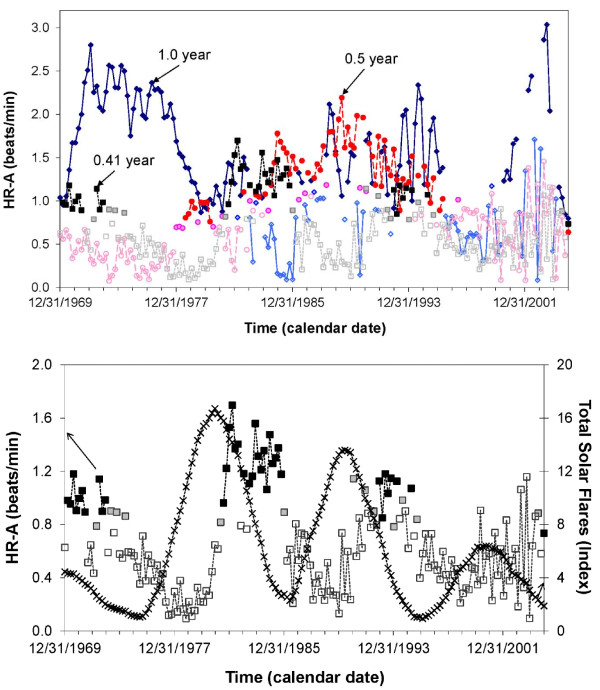
Multiple-component serial section. Heart rate, self-measured a few times each day by a healthy man over several decades, was averaged over consecutive weeks. The weekly averages are fitted with a 3-component model consisting of cosine curves with periods of 1.0, 0.5, and 0.41 year in a 4-year interval moved by 0.2 year throughout the entire record. The time course of amplitudes of the 3 components is shown on top. Solid-filled, light-filled and empty symbols correspond to P-values <0.05, 0.05 < P < 0.10, and >0.10 from the zero-amplitude tests, respectively. Results for the 0.41-year component are reproduced below, where they are compared with the solar flare index that had been reported by physicists to be characterized by an about 5-month (0.41-year) component. The prominence of the about 5-month component in human heart rate follows an about 11-year cycle, which is similar to that characterizing solar flares. © Halberg Chronobiology Center.